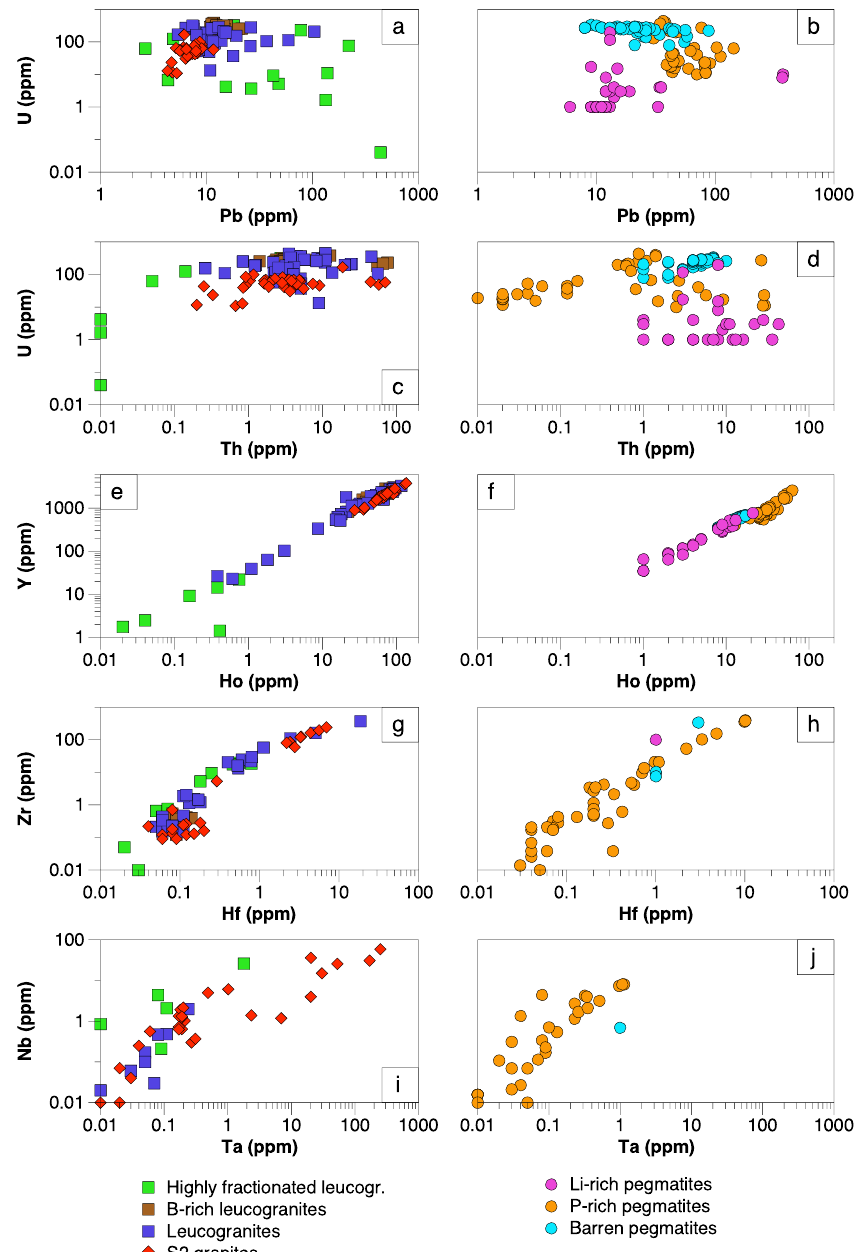
Figure 8. Binary plots of minor trace elements in apatite (all values in ppm): ( a , b ) Pb versus U; ( c , d ) Th versus U; ( e , f ) Ho versus Y; ( g , h ) Hf versus Zr; ( I , j ) Ta versus Nb; from the different granitic and pegmatitic lithologies, respectively.